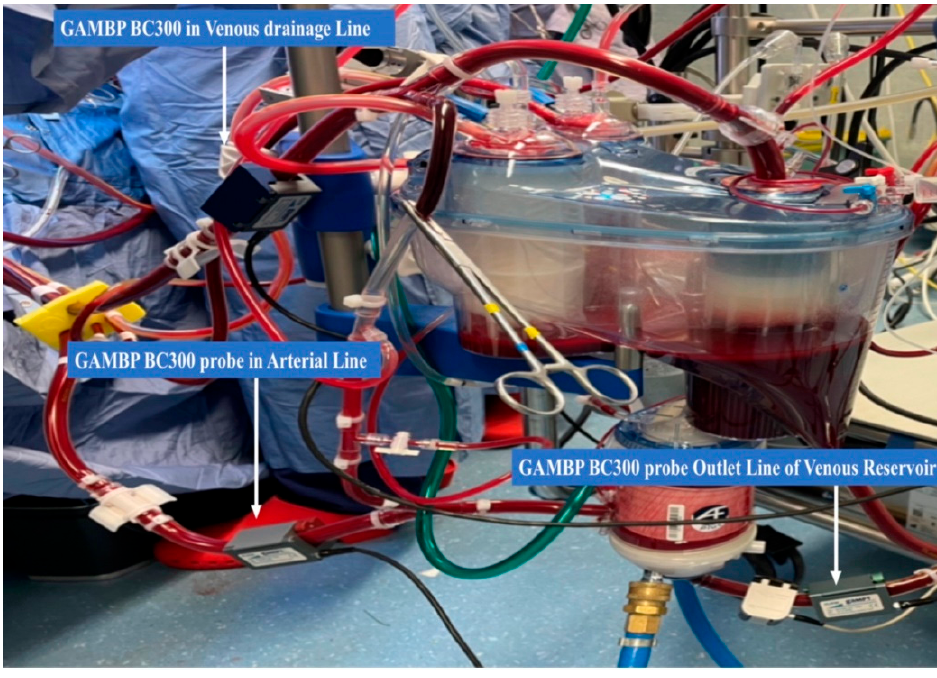
Figure 4. Probes GAMPT BC300 positioning for micro-embolic activity evaluation on Horizon AF PLUS.